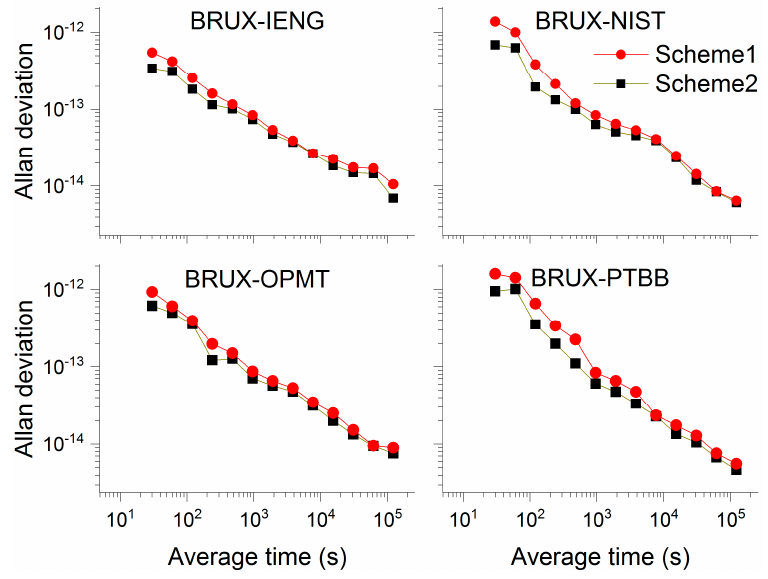
Figure 12. Allan deviation of scheme 1 ( blue ) and scheme 2 ( red ) on four links.